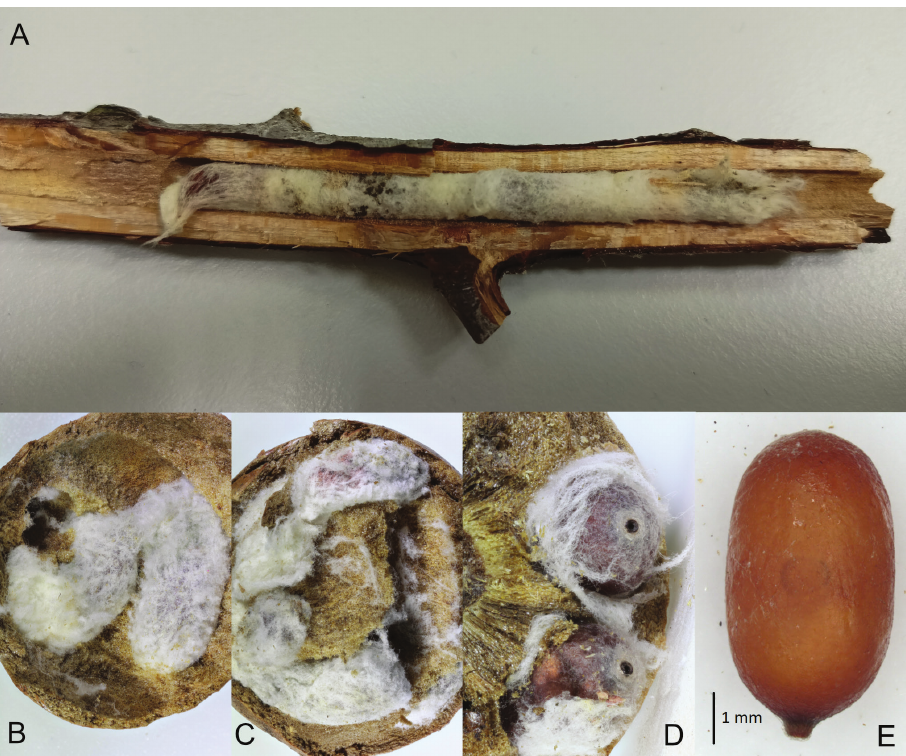
Figure 5. Nests of Pseudoanthidium nanum A nest in a twig of Rosa sp. B, C nests in oak galls of Andricus kollari , D – two cocoons in an oak gall, and E –